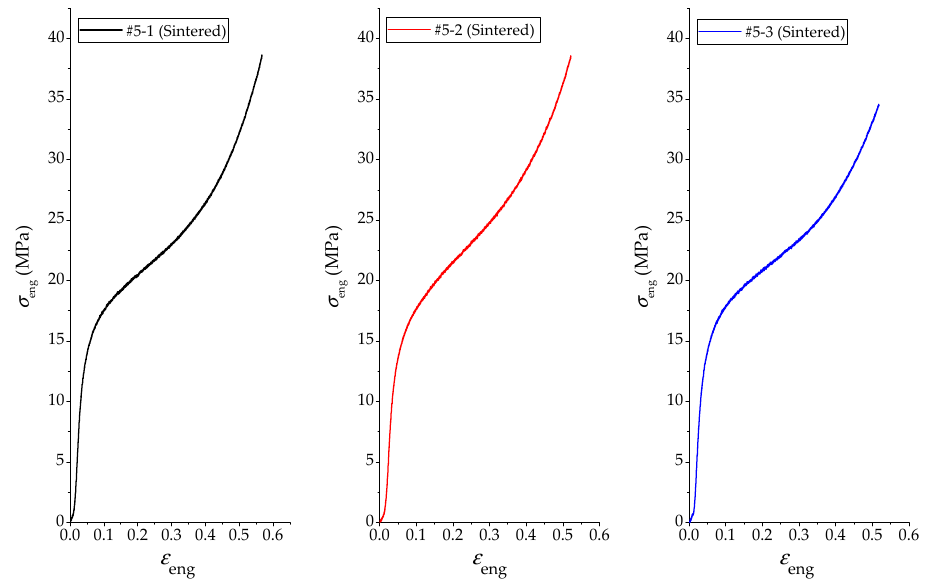
Figure 3. The engineering stress − strain curves of PTFE/Al/Si samples.